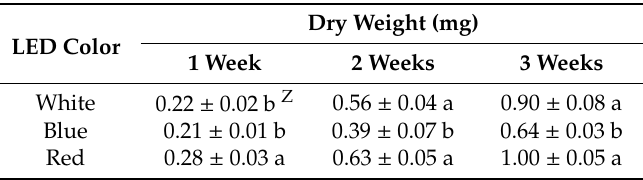
Table 1. Dry weight of Brassica juncea sprouts grown under varying durations of light-emitting diode (LED) illumination.